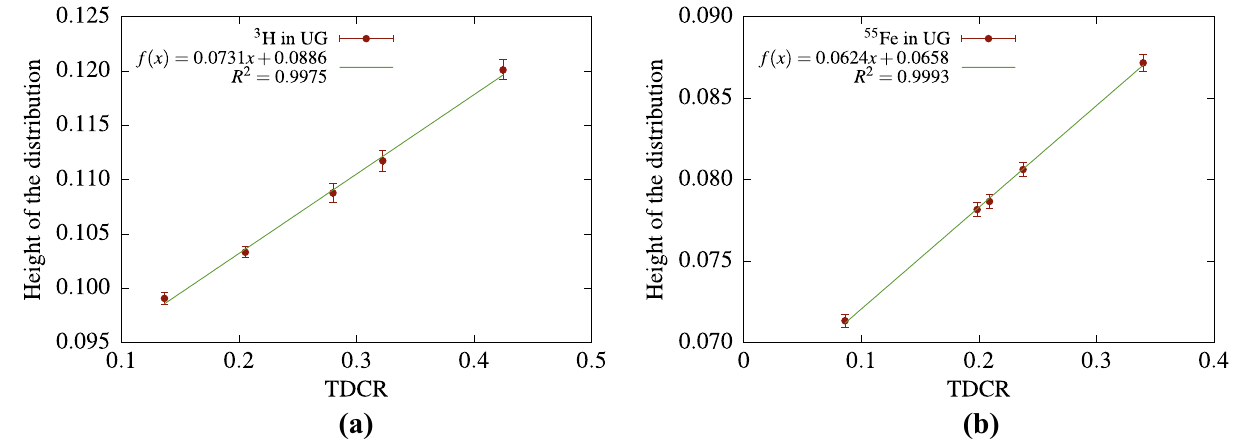
3 55 H ( a ) and Fe ( b ) sources in